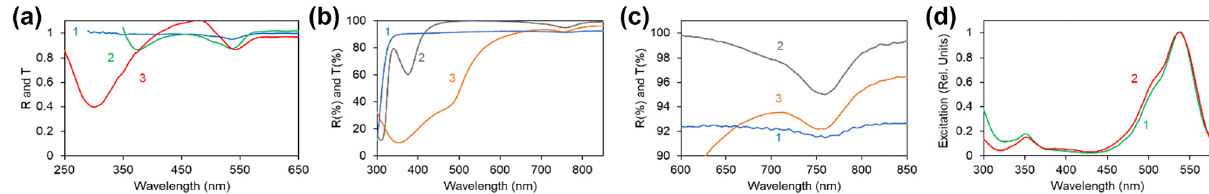
Figure 3: Transmission, reflection, and excitation spectra on top of glass, Ag, and Au. (a) Transmission (1) and reflection (2 and 3) spectra of Rh590:PMMA ( n = 16 g/L) deposited on glass (1), Ag (2) and Au (3). (b) Same for HITC:PMMA films ( n = 30 g/L). (c) Zoomed portion of Figure 3b. (d) Excitation spectra of Rh590 emission on top of glass (1) and Ag (2), n = 128